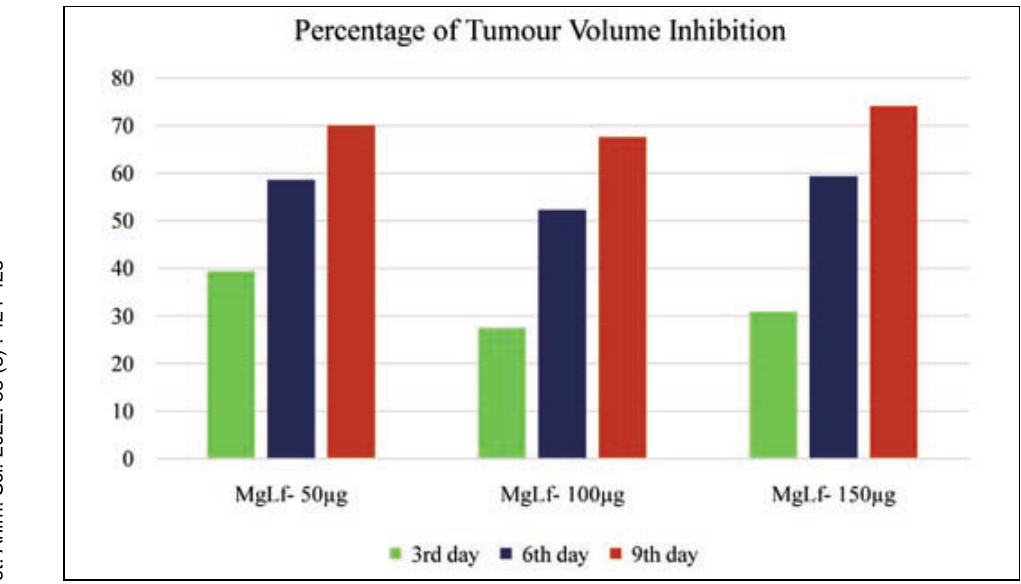
Fig. 1. Percentage tumour volume inhibition of different treatment groups of tumour induced